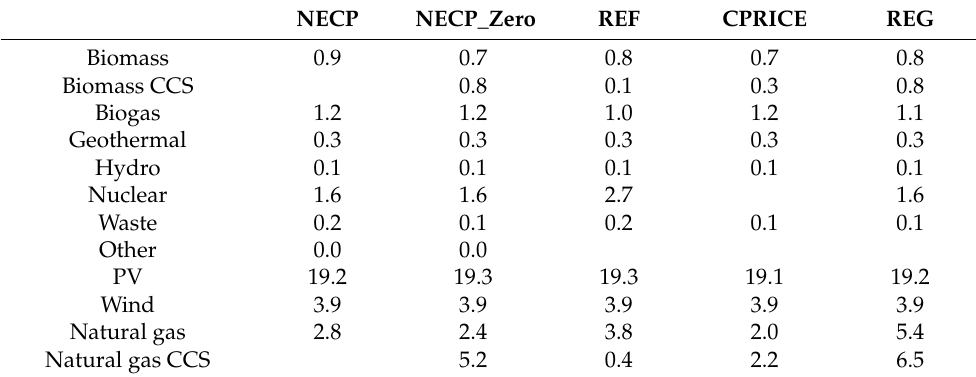
Table 6. Cumulative new installations of electricity generation capacities (GWe).